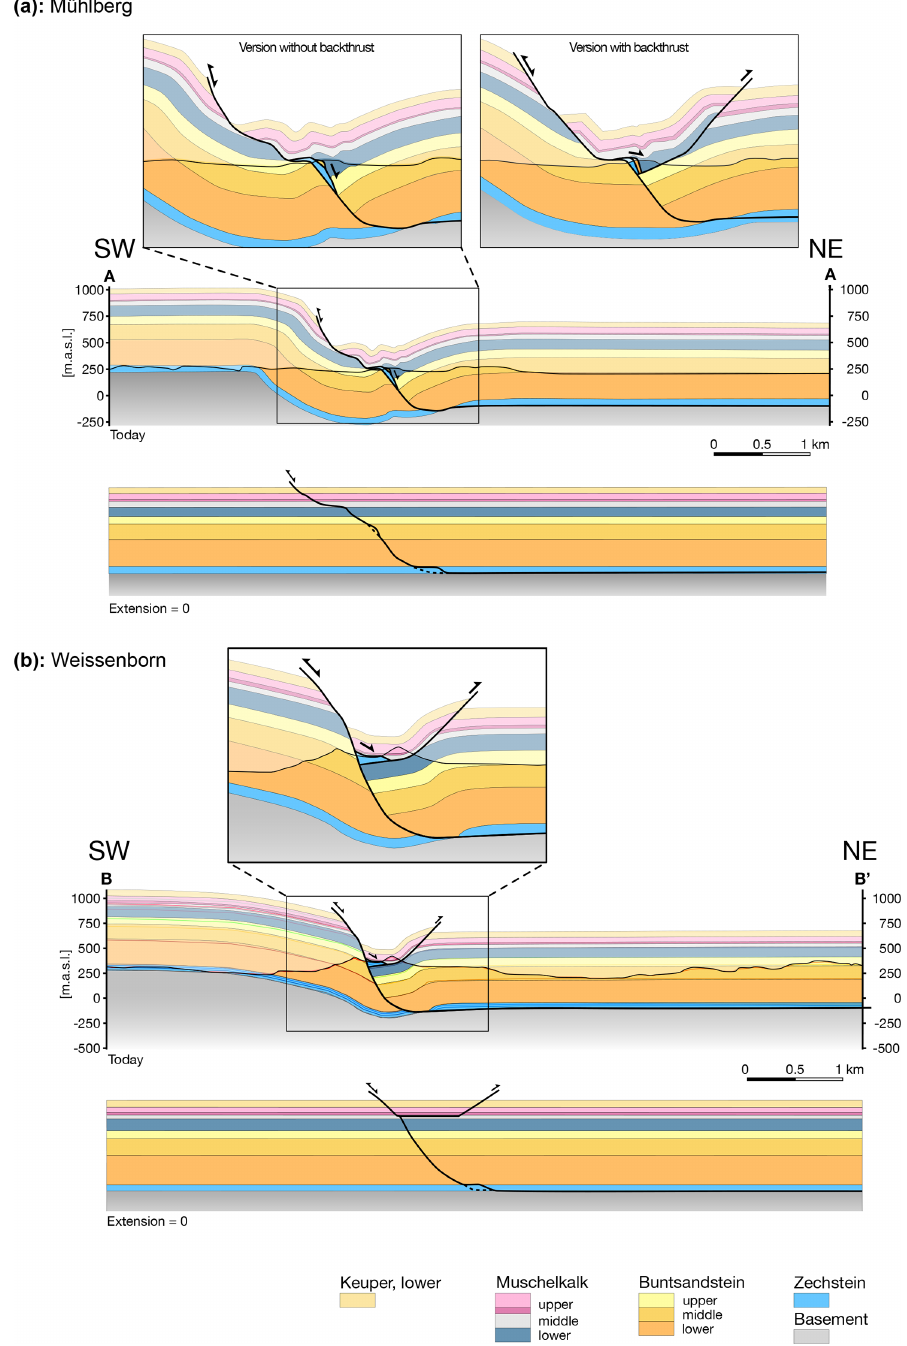
Figure 7. Balanced cross sections of the Sontra Graben. The fault geometry was verified through the forward model in Fig. 6. For section traces, see Fig.